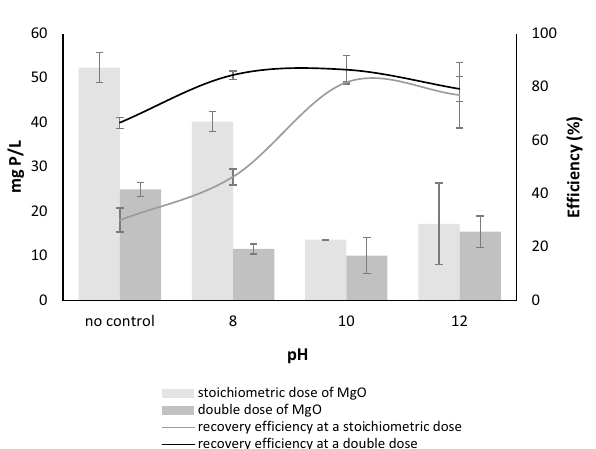
Figure 3. Phosphorus concentration in a supernatant after precipitation with a stoichiometric and a double dose of MgO and the efficiency of phosphorus